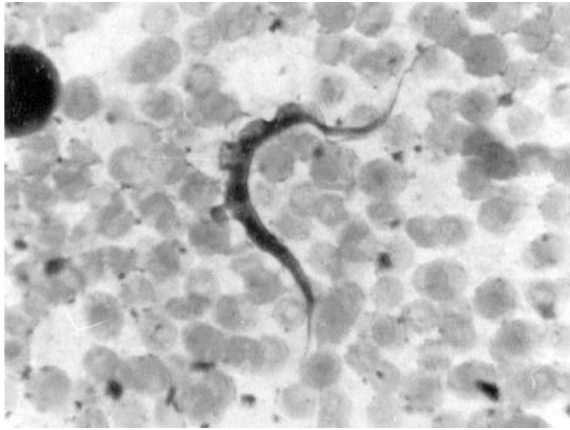
FIG. 1 Blood stream form of Trypanosoma theileri from the infected